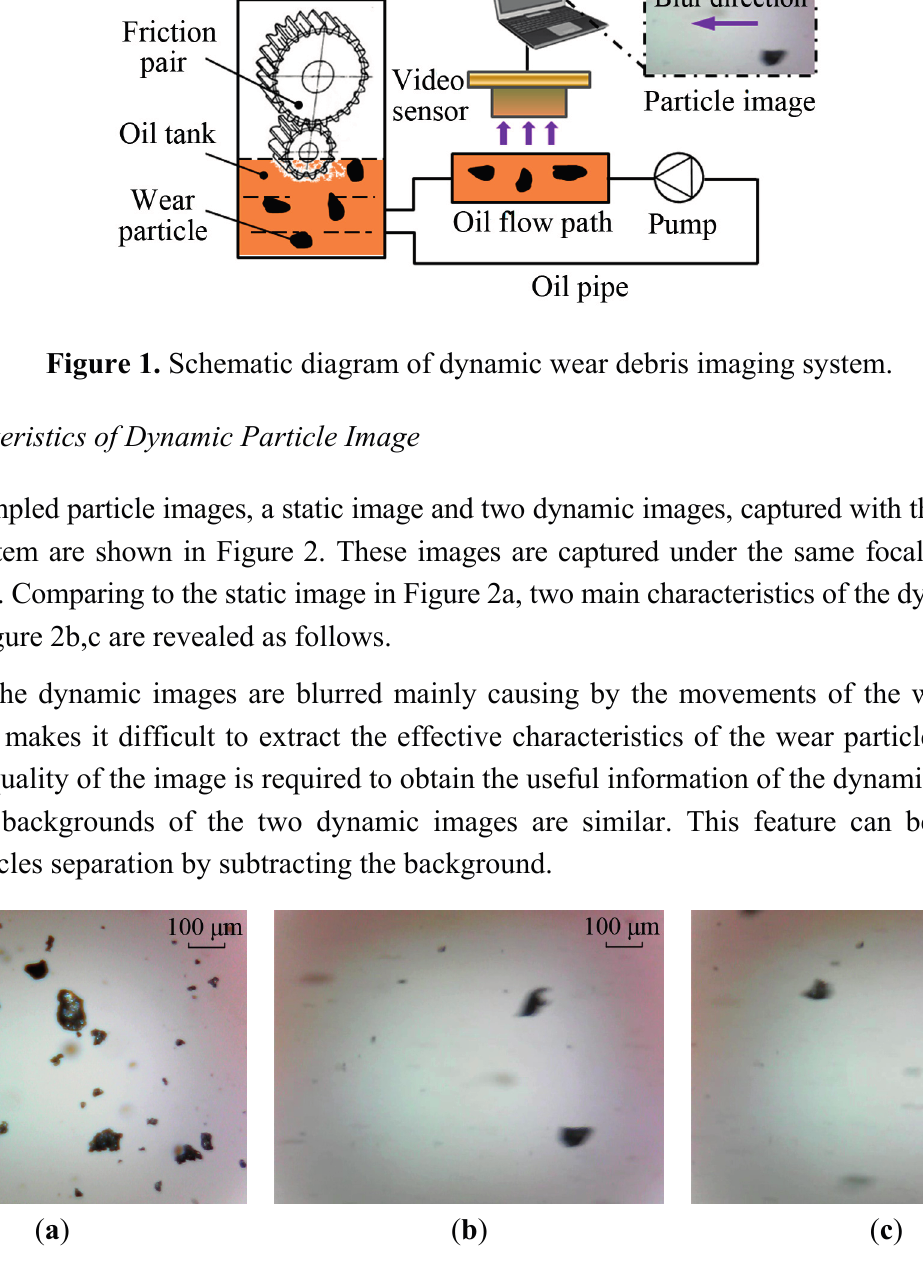
Figure 2. Three typical wear debris images: ( a ) static wear particle image; and ( b , c ) dynamic particle